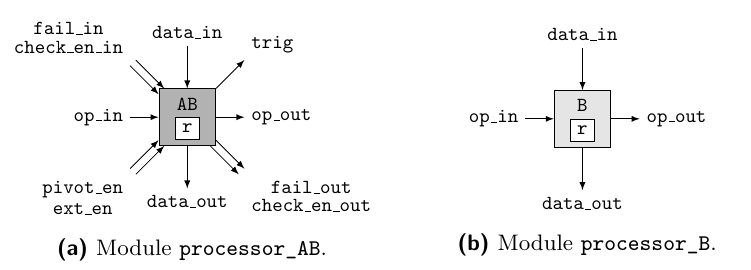
Figure 7: Details of the input and output ports of modules processor_AB and processor_B . The width of op_in and op_out is two